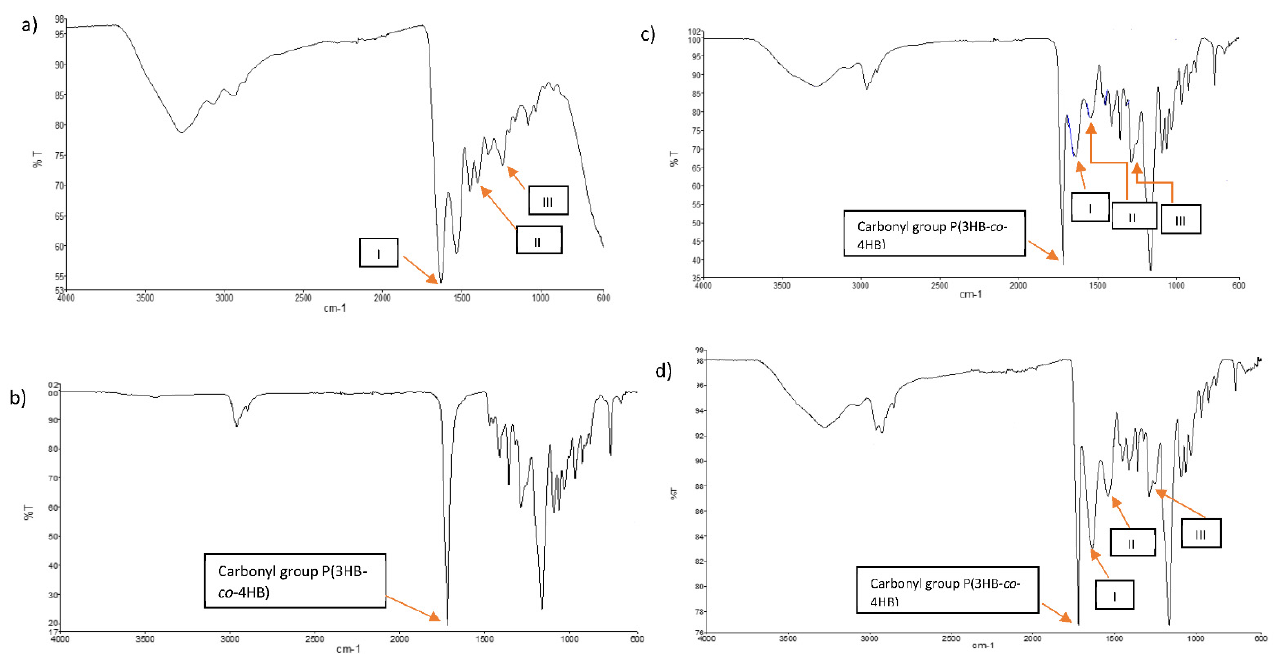
Figure 4. FTIR spectra of scaffolds ( a ) collagen, ( b ) P(3HB- co -4HB), ( c ) SBCC, and ( d ) SCCC. Arrows I, II, III indicate amide I, amide II and amide III, respectively.